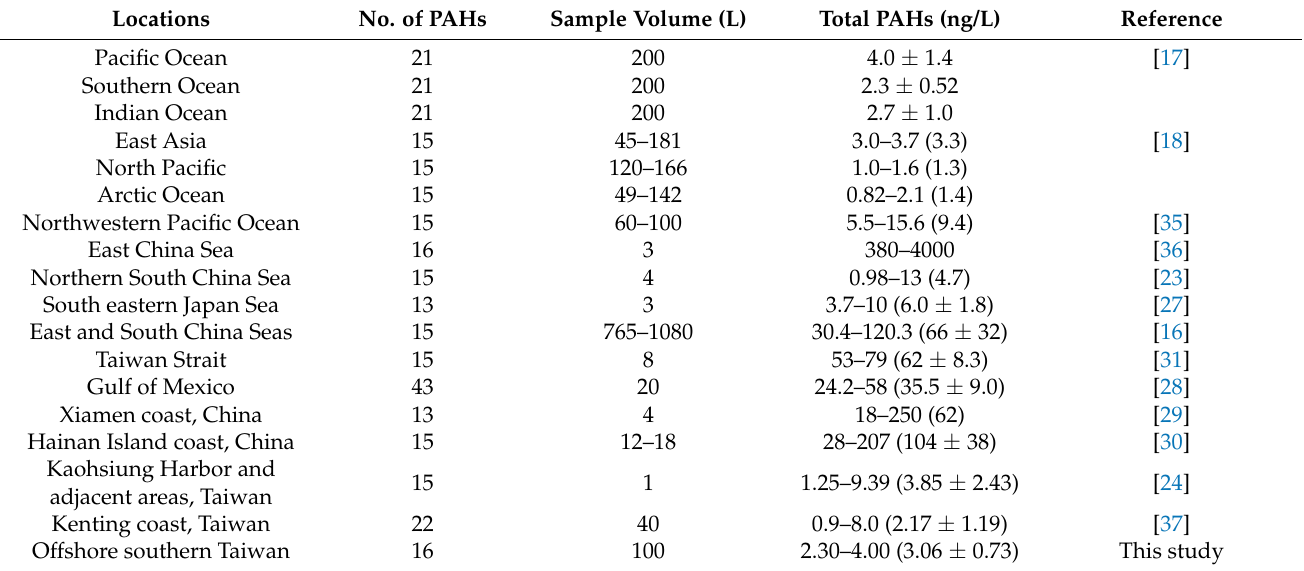
Table 5. Comparing the concentrations of dissolved PAHs in surface seawater reported in different regions of the world.